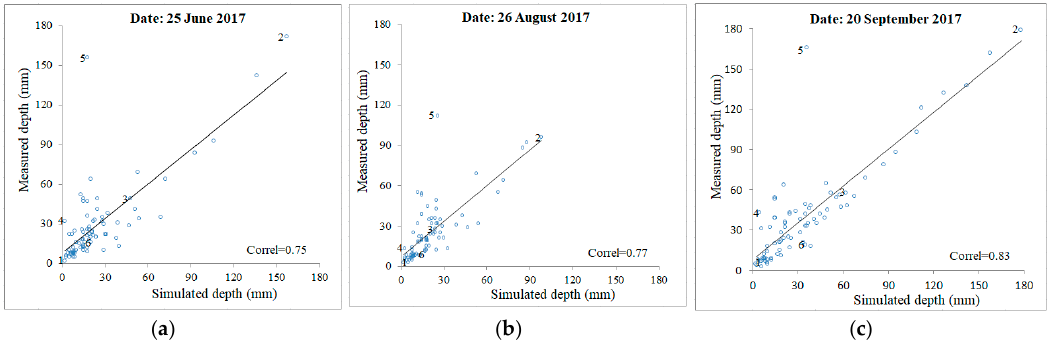
Figure 9. Plots of validation points. ( a ) 25 June 2017; ( b ) 26 August 2017; ( c ) 20 September 2017.